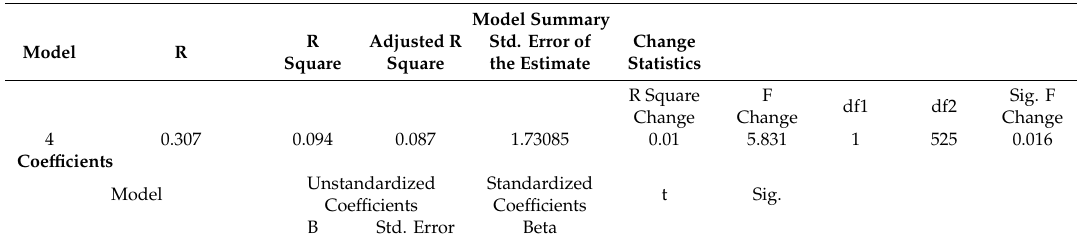
Table 3. Factors a ff ecting the emotional impact of forests on respondents.